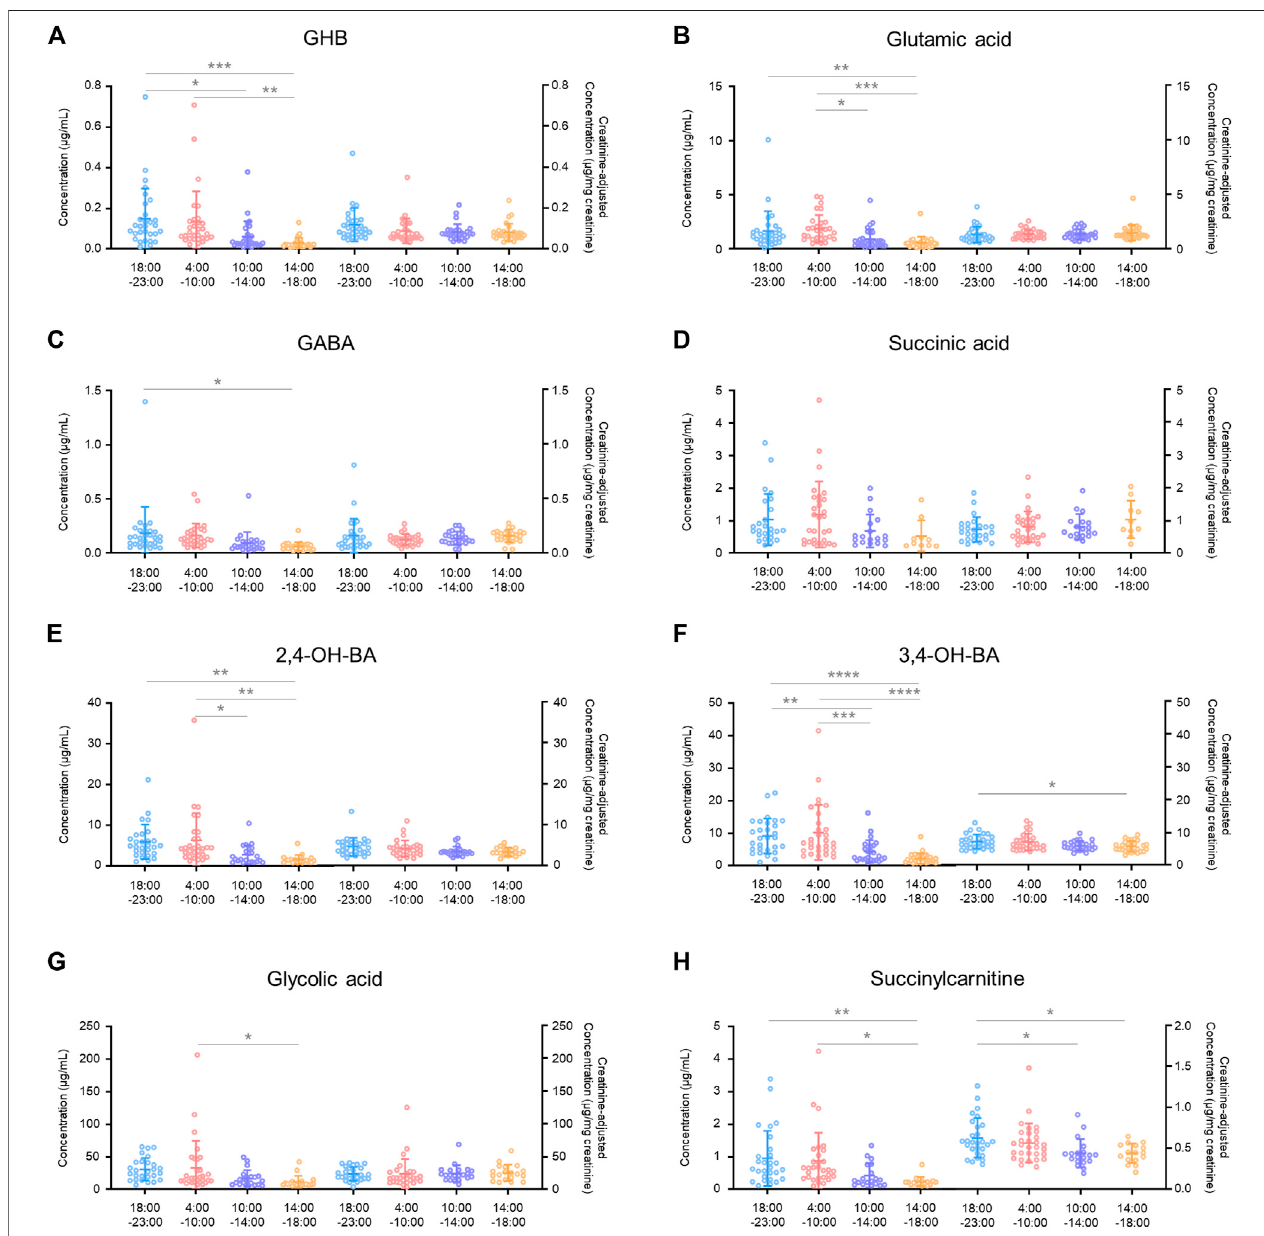
FIGURE5| Intra-day variabilitiesinunadjustedandcreatinine-adjustedconcentrationsofGHB (A) ,glutamicacid (B) ,GABA (C) ,succinicacid (D) ,2,4-OH-BA (E) , 3,4-OH-BA (F) , glycolic acid (G) , and succinylcarnitine (H) . Horizontal lines within the scattered dots indicate means ± standard deviations. Values less than the limit of quanti fi cation were excluded. * p < 0.05, ** p < 0.01, *** p < 0.001, **** p < 0.0001.